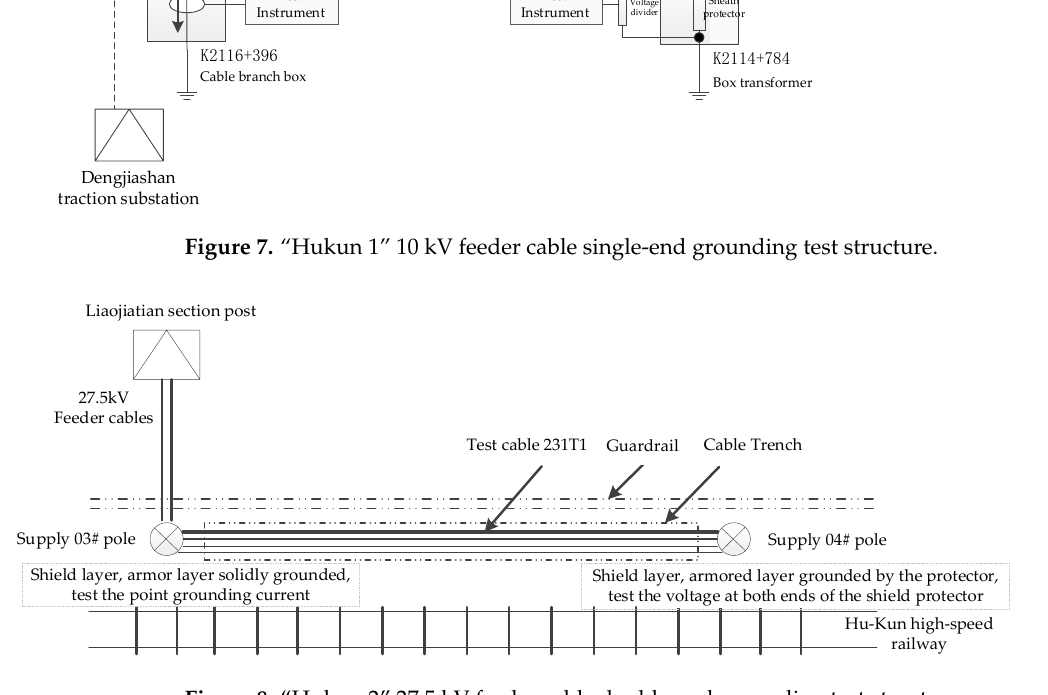
Figure 9. “Nankun 1” 10 kV feeder cable double-end grounding test structure.